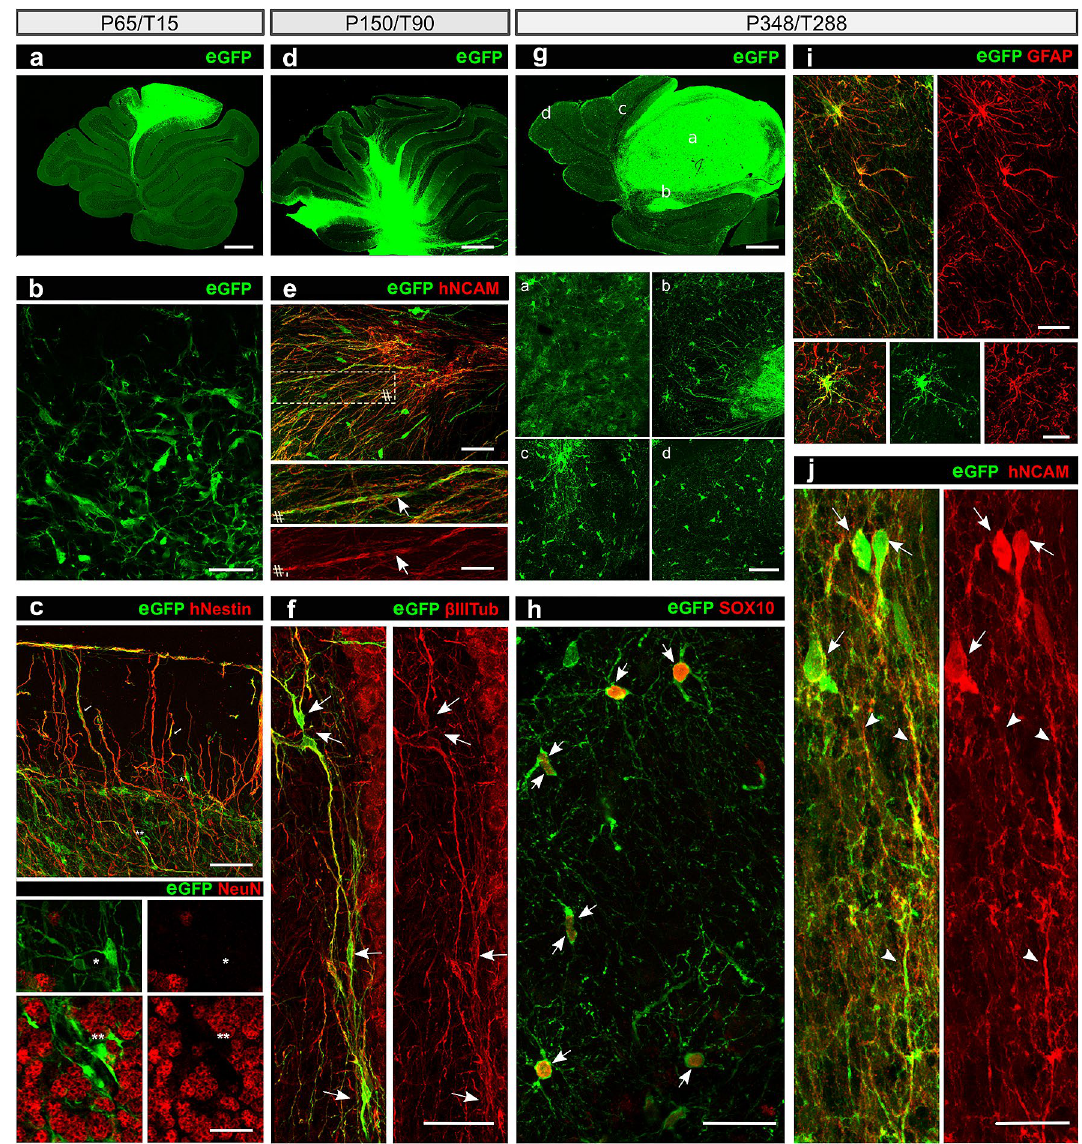
Figure 2. Representative photomicrographs of hiPSdNP transplanted into the cerebellum of adult NOD-SCID mice, time epochs are organized in columns. ( a , d and g ) Cerebellum sagittal sections. At increasing survival times the portion of cerebellum containing eGFP positive cells derived from the transplant increases due to cell dispersal and proliferation of neural precursors and glial cells. Scale bars: 100 µm. ( b ) Mouse cerebellum, at short survival times (15 days after the transplant) the majority of the engrafted cells maintain an undifferentiated morphology. Some cells bear distinct processes. Scale bar: 20 µm. ( c ) Mouse cerebellum survival as in B, sagittal section stained with anti hNestin (upper image) and anti NeuN (lower images) antibodies. Arrows mark examples of neurites double-labeled by antibody against eGFP and hNestin, asterisks indicate corresponding positions in all pictures, eGFP positive hiPSdNP derived cells are NeuN negative, while many of the surrounding host cells are NeuN immunopositive. Scale bars: 20 µm (upper), 10 µm (lower). ( e ) Mouse cerebellum 3 months after the transplant neuronal differentiation is ongoing with many process bearing cells immunopositive for hNCAM. The boxed area is enlarged at the bottom in order to show the close correspondence of eGFP and hNCAM positivity in neurites. Arrows indicate processes double positive for eGFP and hNCAM. Scale bars: 10 µm (upper), 5 µm (lower). ( f ) Mouse cerebellum 3 months after the transplant many neuronal cells are immunopositive for ß-III tubulin (arrows). Scale bar: 15 µm. ( g ) Mouse cerebellum 288 days after the transplant, higher magnification pictures of the areas labeled by the letters are provided below the low magnification image, showing the different morphologies and migration pattern of the cells derived from the transplanted hiPSdNP. Scale bars: 100 µm (upper image), 30 µm (lower four images). ( h ) Same survival as in G, many transplant derived cells differentiated into SOX10 positive cells (arrows). SOX10 is considered a marker of immature oligodendrocytes and myelinating oligodendrocytes 53 Scale bar: 15 µm. ( i ) Same survival as in G, examples of eGFP positive hiPSdNP derived cells immunopositive for GFAP showing an astrocytic morphology. Scale bars: 10 µm. ( j ) Same survival as in G eGFP positive hiPSdNP derived neurons (arrows) positive for hNCAM with extensive processes (arrowheads) are also present at these survival times. Scale bar: 10